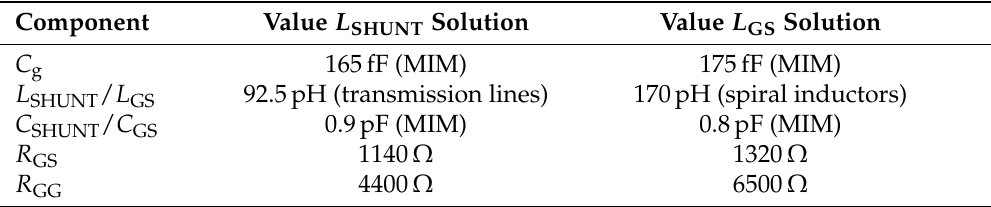
Table 2. Circuit level component values of the designed stacked cells.